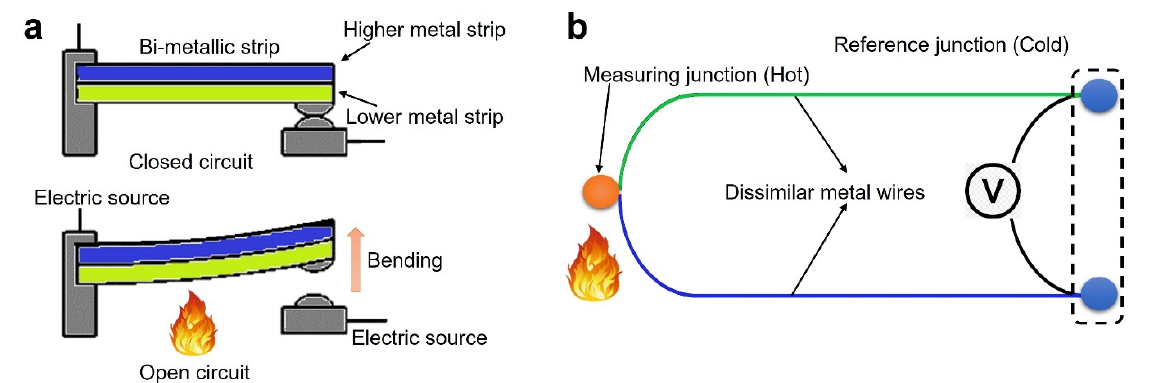
Figure 3. Heat sensors: ( a ) bi-metal strip sensor working principal; ( b ) thermocouple working principal.